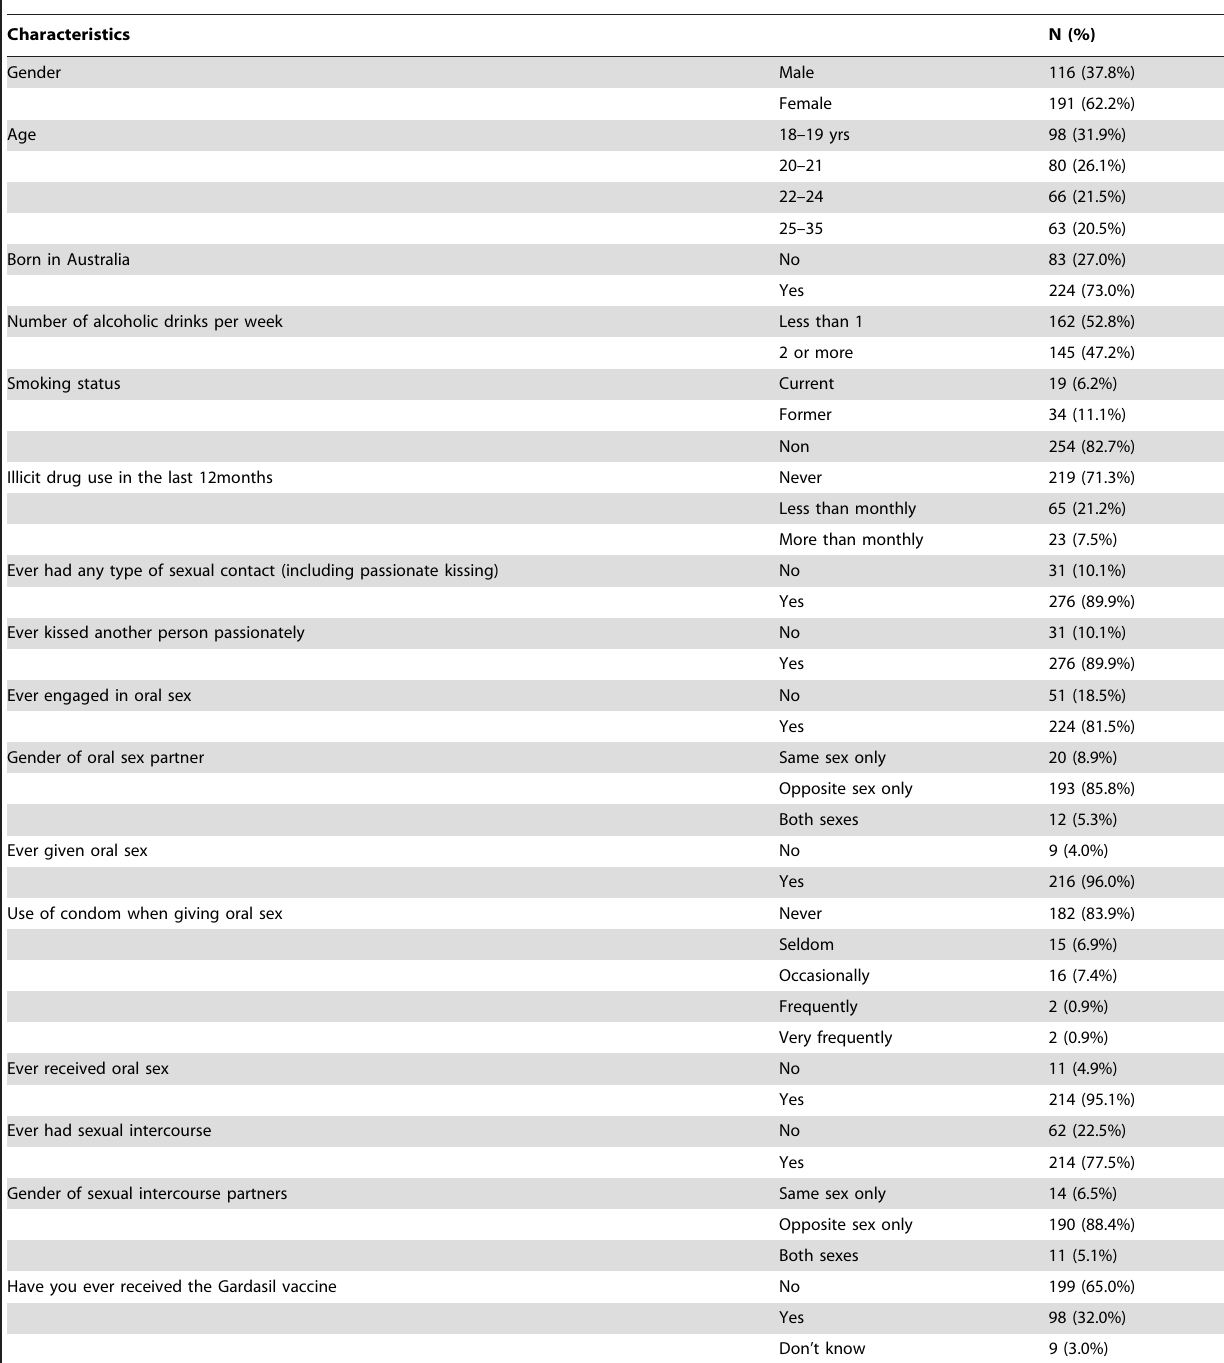
Table 1. Selected characteristics of the 307